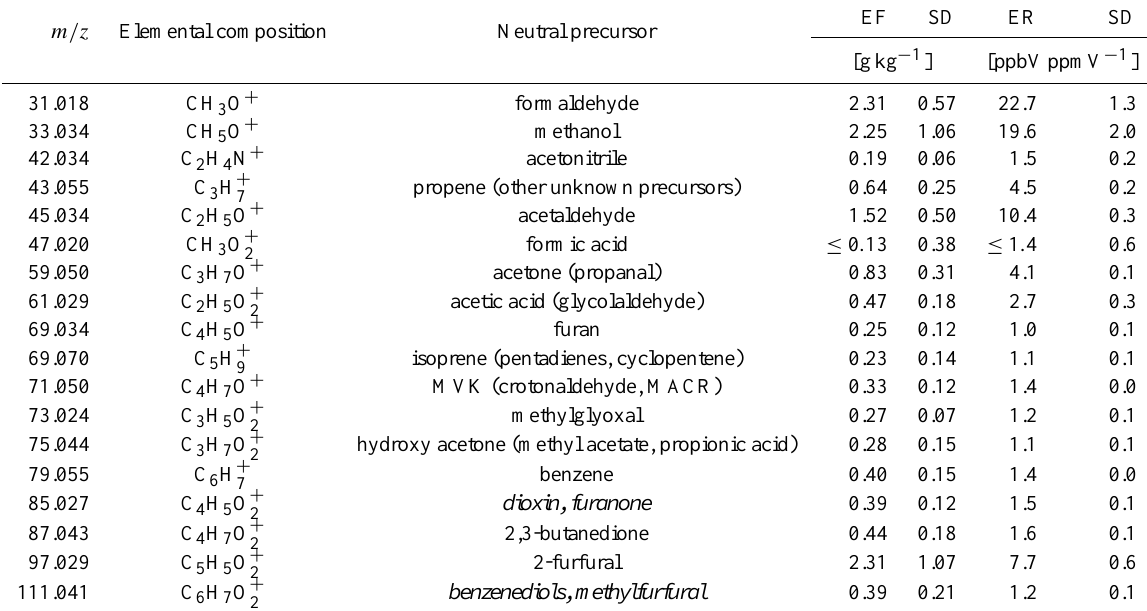
Table 3. Measured accurate m/z , elemental composition C w H x N y O + z of the detected ion, neutral precursor assignment based on literature information (significant interferants in parentheses, tentative assignments in italic), emission factor (EF) and standard deviation (SD), and emission ratio (ER) and standard deviation for all detected NMOGs with ER X / CO >1ppbVppmV − 1 .